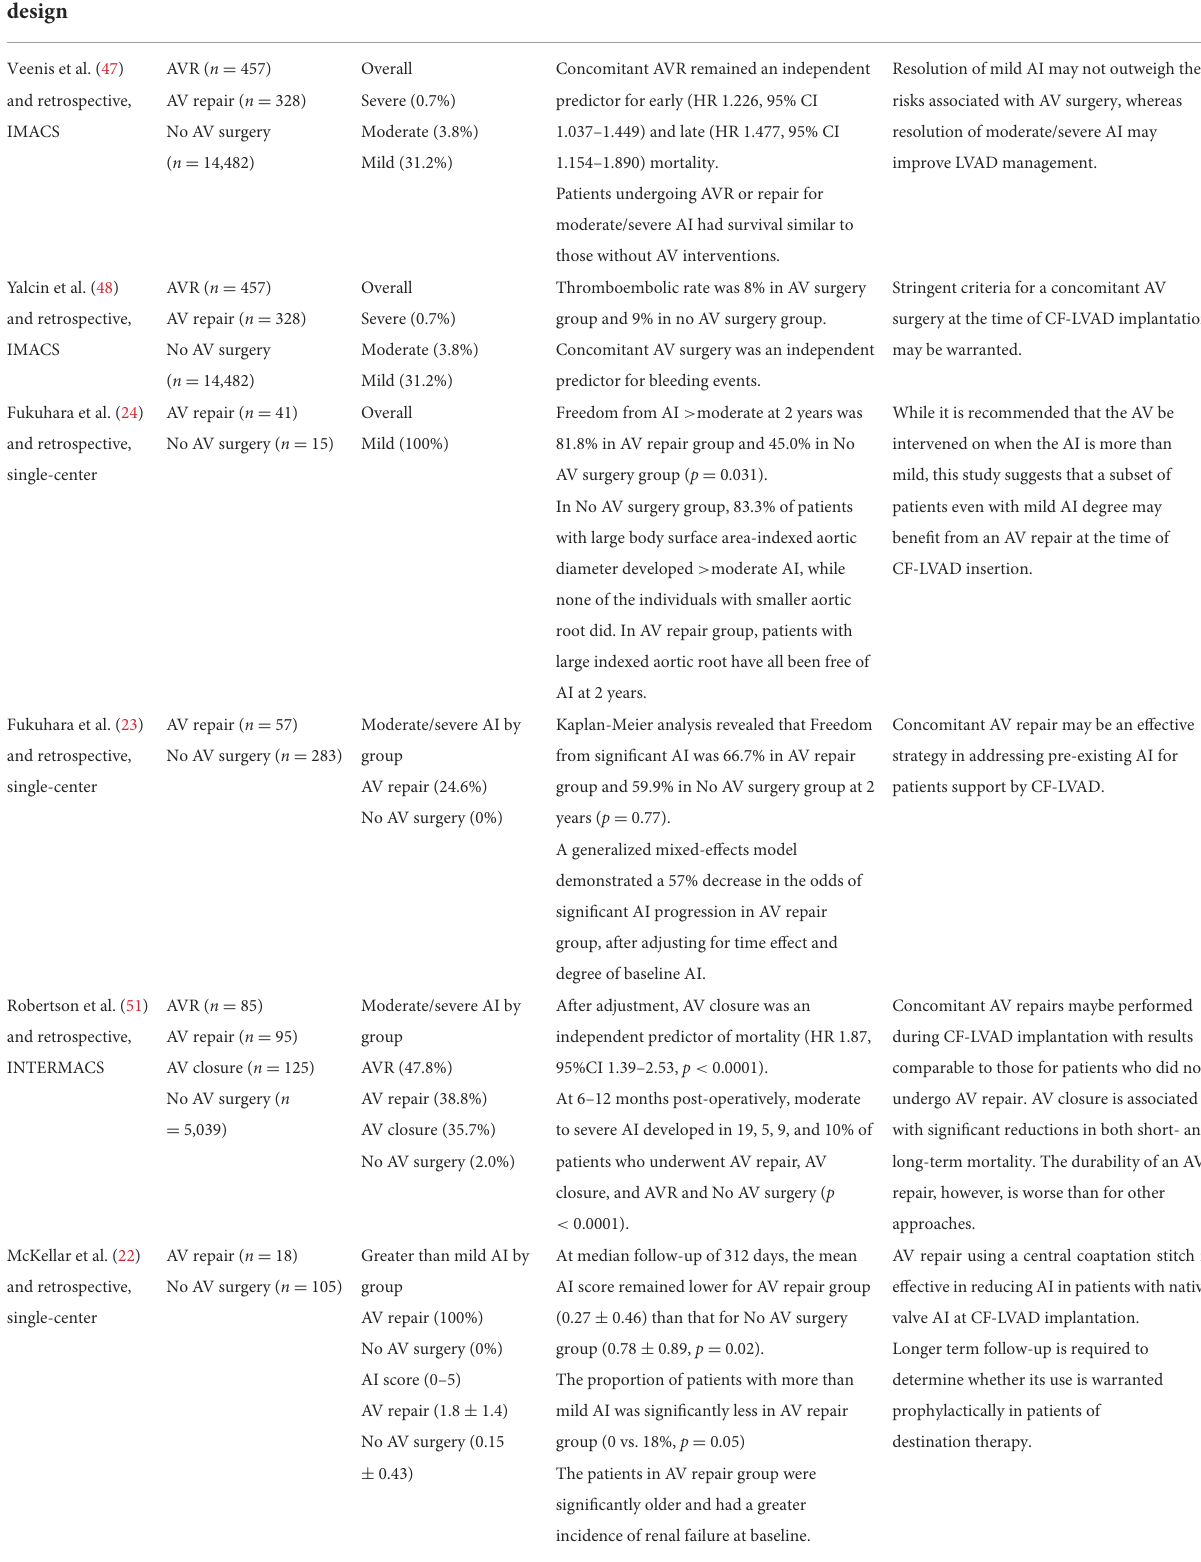
TABLE 1 Efficacy of concomitant aortic valve interventions at the time of continuous-flow LVAD